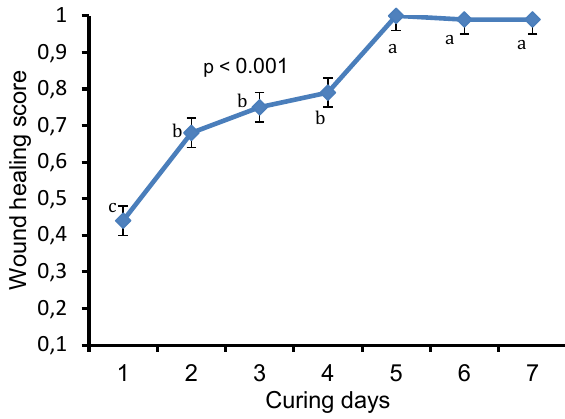
Figure 2: Wound healing as affected by curing method averaged across 7-day curing period. Bar values (least square means ± SEM, n = 3). Least square means with the same letters are not signifi- cantly different (p > 0.05)